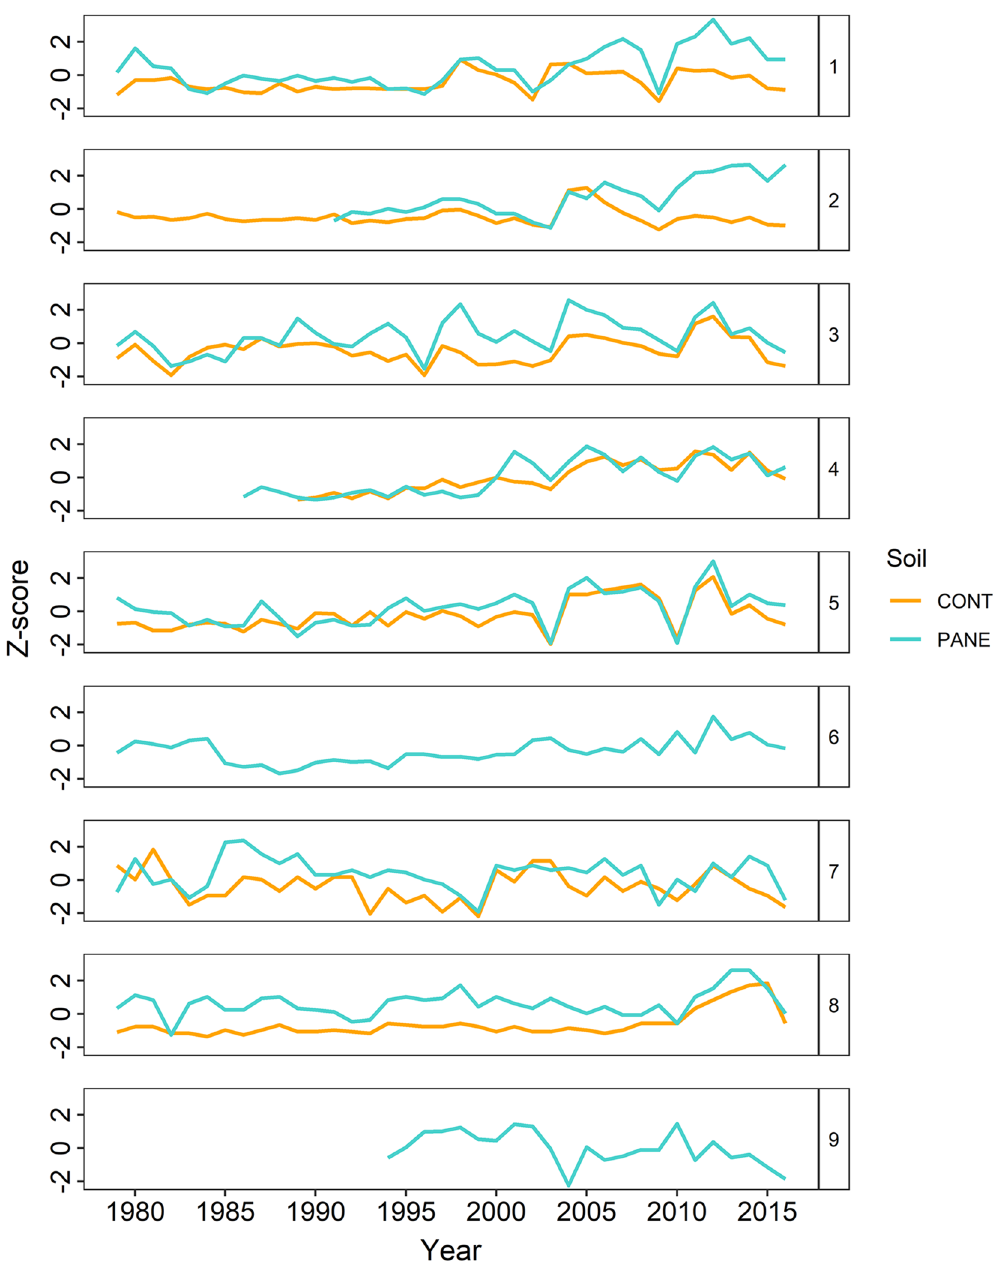
Figure 4. Time series of ring width index (RWI, i.e. Z-scores) of Salix glauca L. from nine sites along the Nuuk Fjord (Southwest Greenland). Rings that evidence Eurois occulta L. outbreaks are found for the years 2003 and 2010 (Iffiartarfik, Sandnes and Austmannadal-1 (V52a)) and 2002 and 2009 (Austmannadal-2 (V53d) 16 ). These rings have been excluded from the analysis. Data represent the site means and colours identify samples from control (CONT) and past anthropogenic nutrient enrichment (PANE)